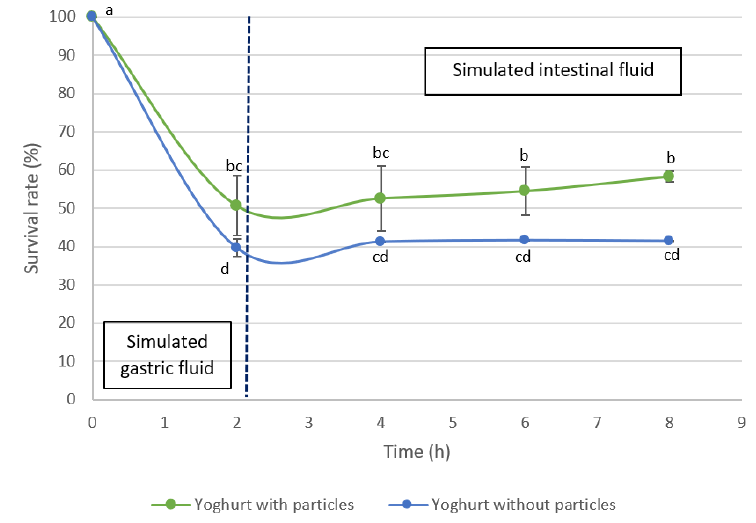
Figure 6. Viability of probiotic bacteria present in yogurt with particles and without particles during simulated gastrointestinal digestion. Different letters represent statistically significant differences between samples during simulated digestion (Tukey test p <